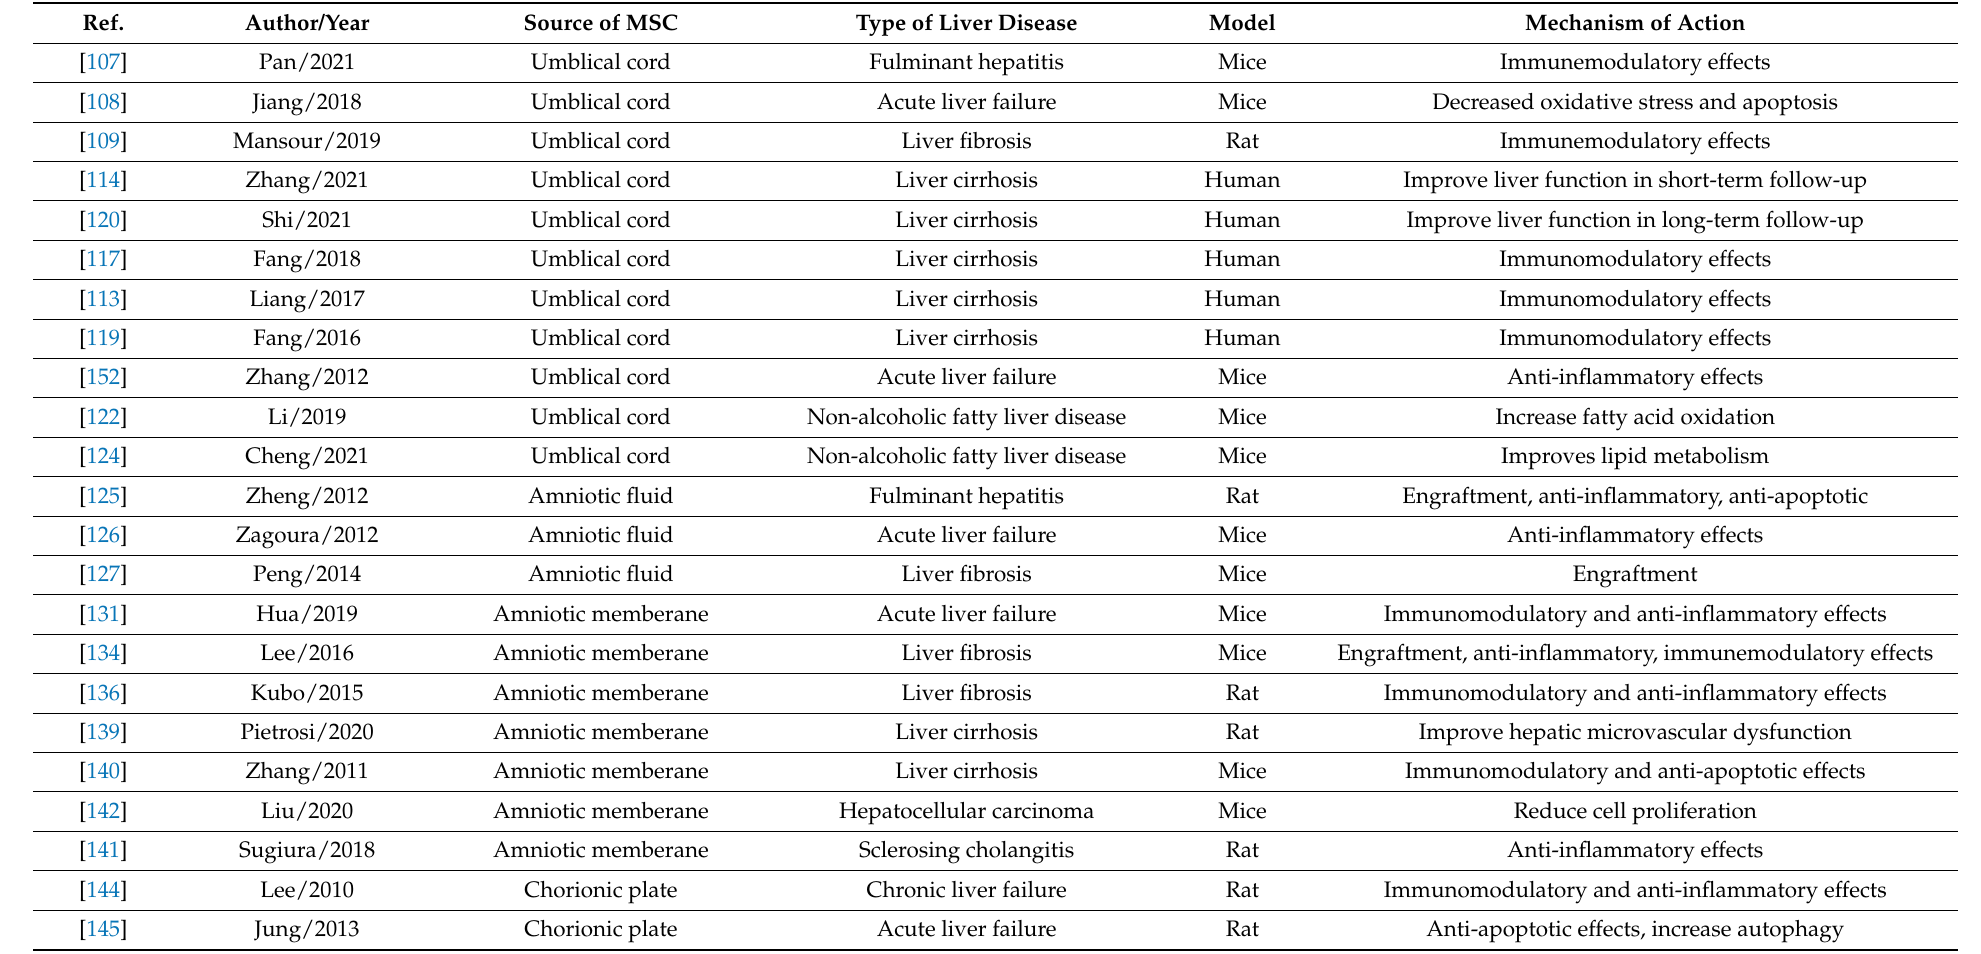
Table 1. Selected recent preclinical and clinical trials using extra embryonic MSCs in liver diseases.